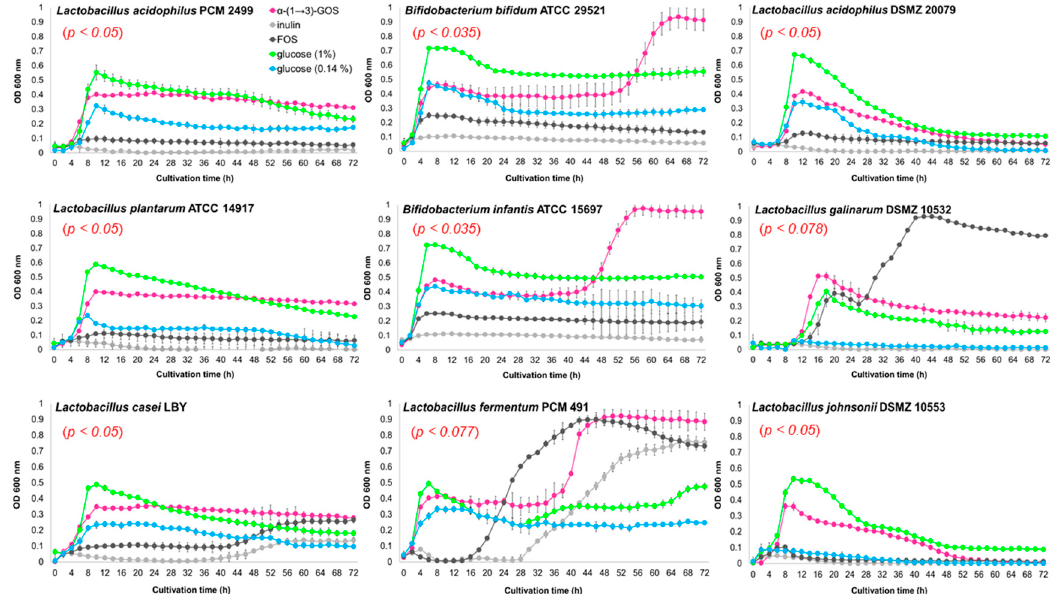
Figure 2. Growth curves of Lactobacillus and Bifidobacterium strains in basal medium supplemented with α -(1 → 3)-glucooligosaccharides ( α -(1 → 3)-GOS), fructooligosaccharides (FOS), inulin, and glucose. The number of bacteria is reported as a change in optical density. The results are given as means ± SD of triplicate samples.